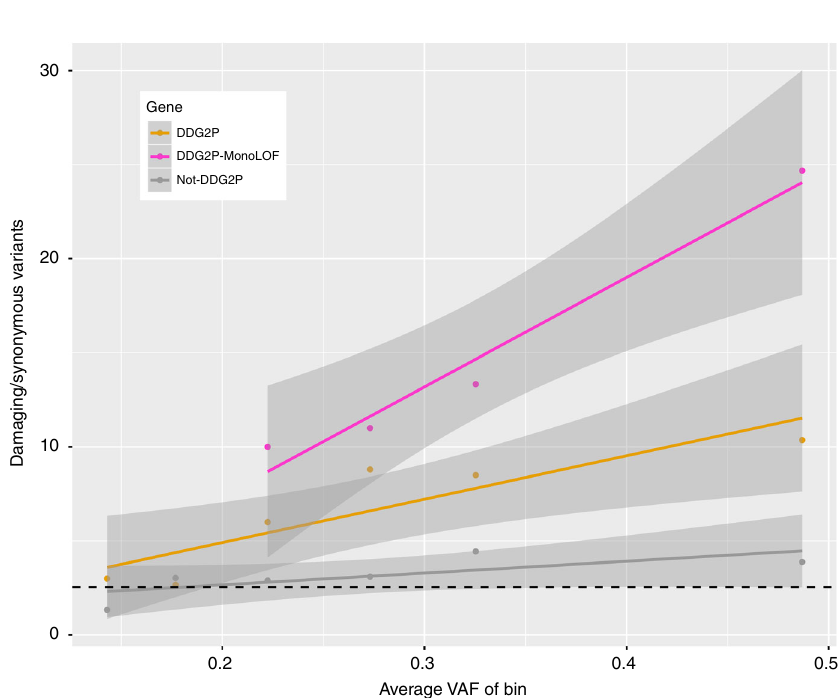
Fig. 7 Enrichment of damaging variants with level of mosaicism. The exome sequencing variant allele fraction (VAF) for candidate DNMs is plotted against the number of damaging (loss-of-function and functional) variants divided by the number of synonymous variants in each of six VAF bins (0.10 – < 0.15, 0.15 – < 0.20, 0.20 – < 0.25, 0.25 – < 0.30, 0.30 – < 0.35 and >0.35). The number of variants in each VAF bin was further divided into three subgroups of genes, and the signi fi cance of the linear regression coef fi cient versus the null was assessed using a Z-test: genes not currently known to be DD-associated (Not-DDG2P, gray; p = 0.03), genes known to be DD-associated (DDG2P, orange; p = 0.00007), and known monoallelic DD-associated genes with a loss-of-function mechanism (DDG2P-MonoLOF, magenta; p < 0.00001). Gray zones represent 95% con fi dence intervals. Null values assuming no enrichment (dotted black line) were calculated from published values of expected numbers of variants in each class based on ExAC, adjusted for indels, and